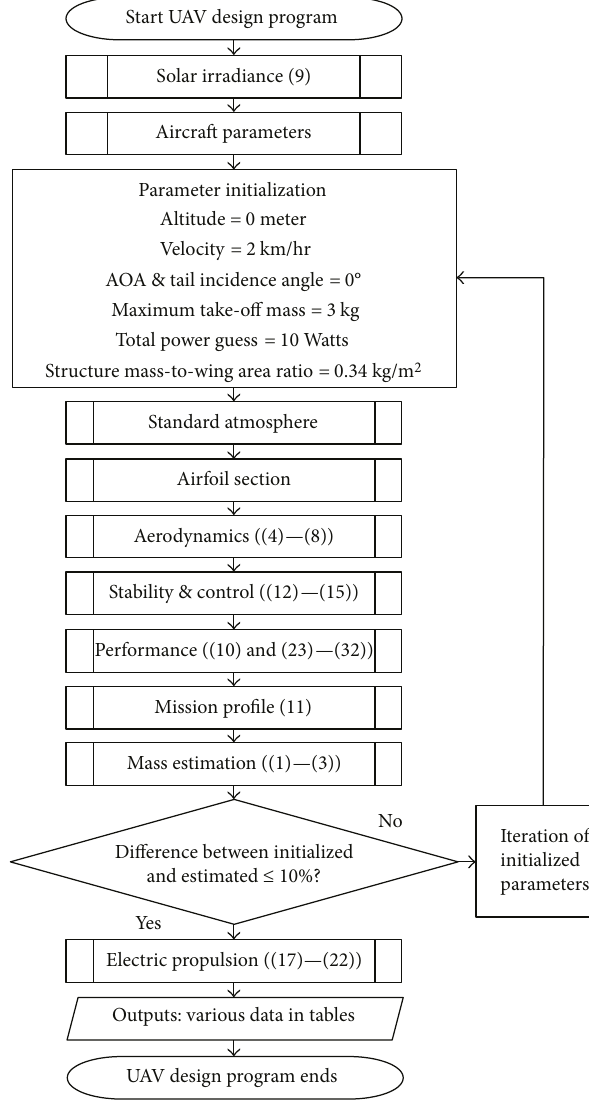
Figure 2: UAV design algorithm fl